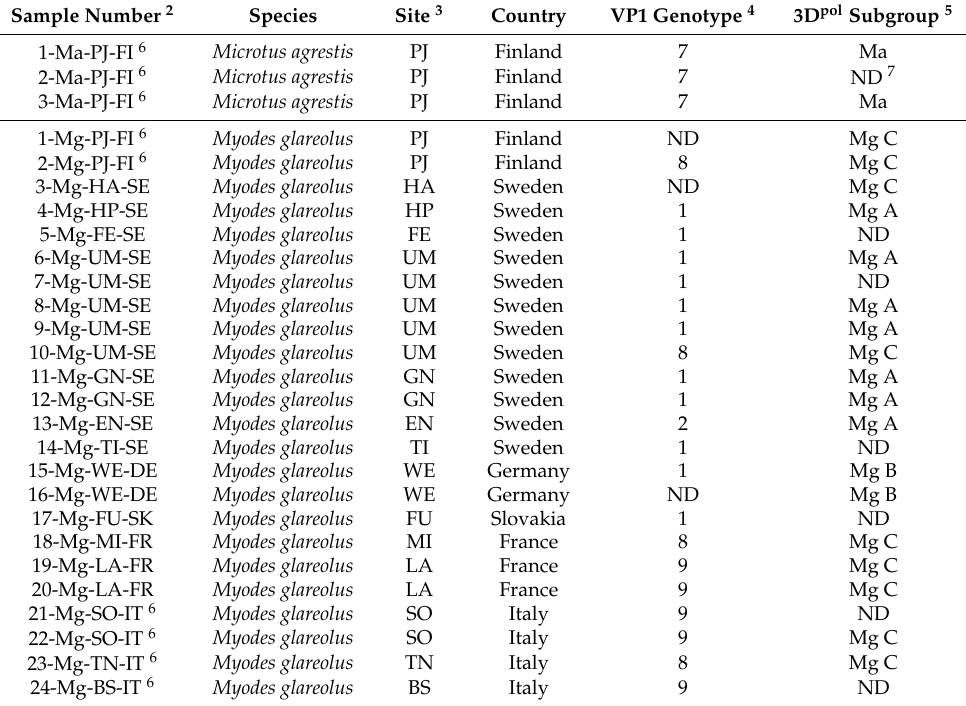
Table 1. List of LV RT-PCR-positive rodent samples from Europe with sequences available for analysis 1 , including geographical origin, VP1 genotype and 3D pol phylogenetic subgroup.